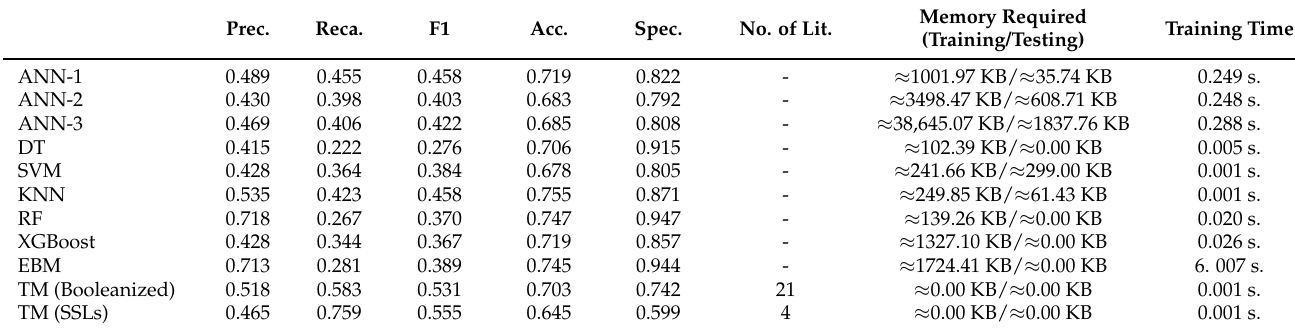
Table 16. Performance comparison for Breast Cancer dataset.